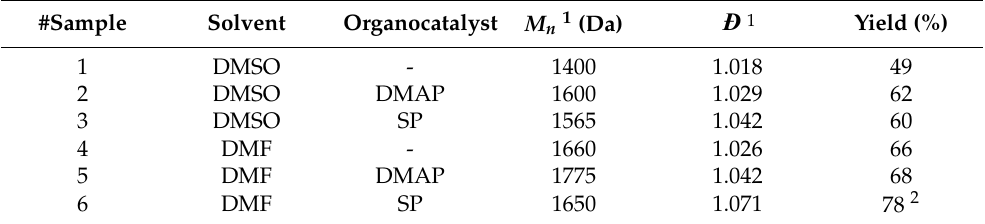
Table 1. CDCL synthesis in different media at 120 °C using β - CD/ε - CL molar ratio of 1/8, [ε -CL] = 1.8 M, [organocatalyst] = 0.225 M, measured after 96